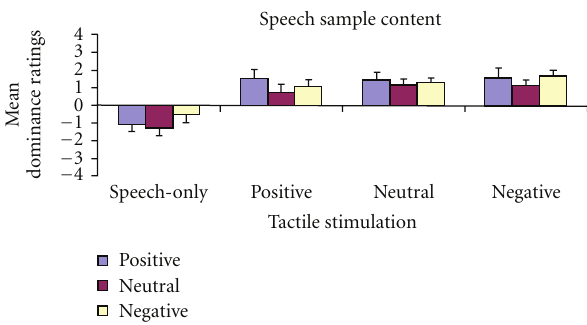
Figure 10: Means and SEMs for the ratings of the stimulus